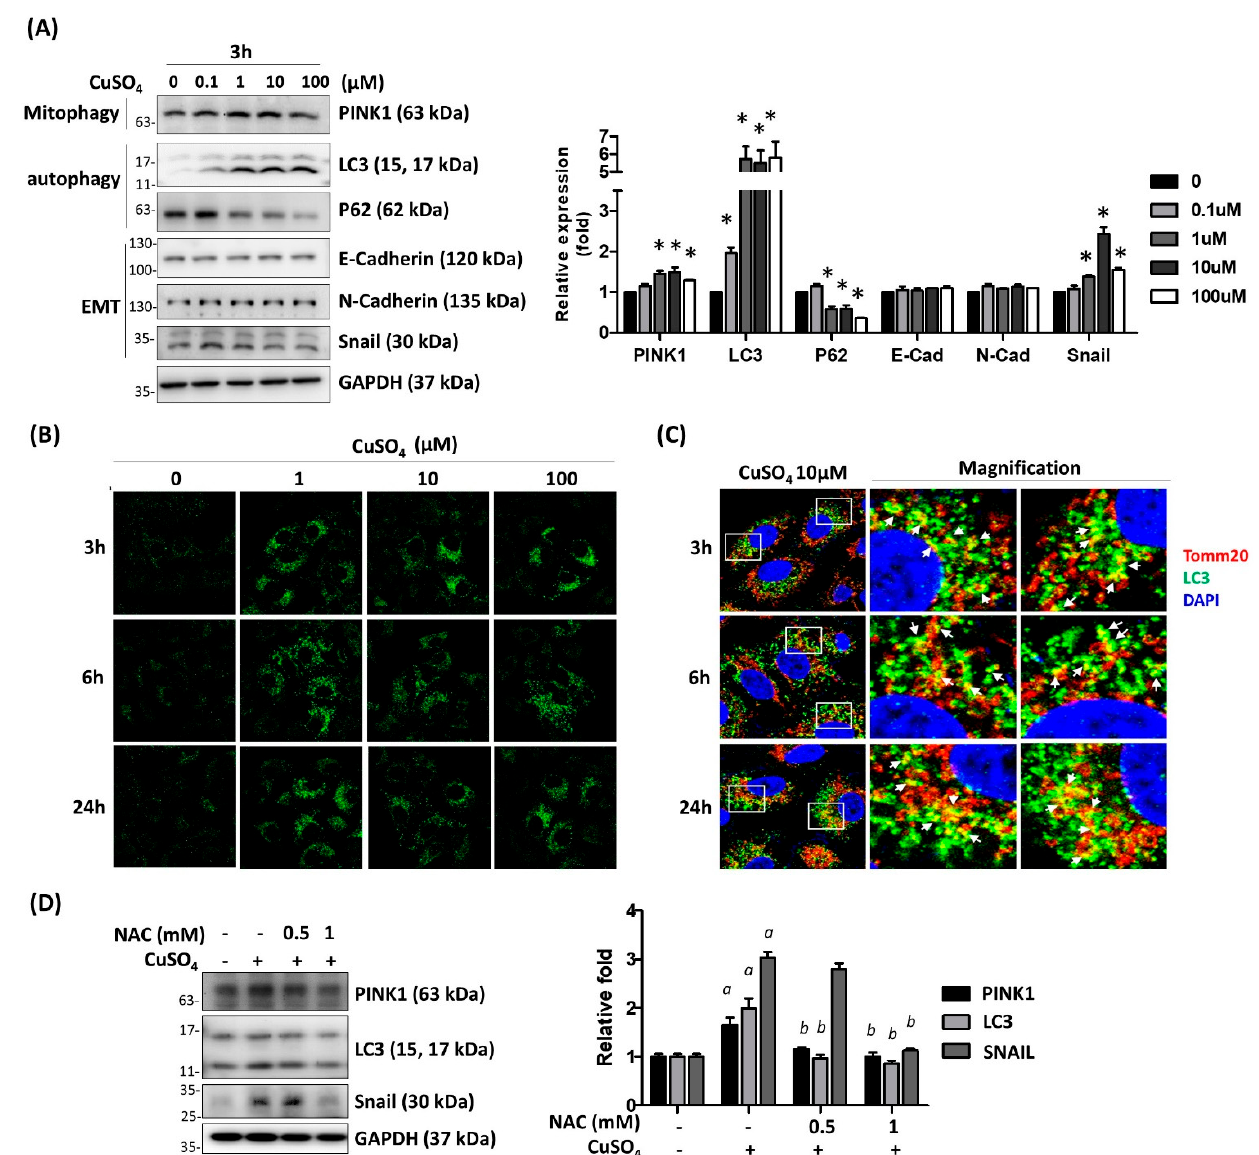
Figure 3. CuSO 4 induced autophagy and mitophagy of lung epithelial cells. ( A ) A549 cells were treated with various doses of CuSO 4 for 3 h. The protein expressions of mitophagy-, autophagy-, and EMT-related proteins were examined by Western blot. The quantitative results were shown in the right panel. Mean ± SEM were shown. *: p < 0.05. ( B ) A549 cells treated with various doses and time periods were fixed and applied to immunofluorescence staining using antibodies against LC3. ( C ) Co-localization of LC3 (green color) and Tomm20 (red color, indicating mitochondria) was shown in yellow color. ( D ) A549 cells were pretreated with 0.5, 1 mM NAC. After 2 h of treatment, the cells were treated in combination with 10 µ M CuSO 4 for 3 h, followed by Western blot analysis. a : p < 0.05 compared with the control group. b : p < 0.05 compared with CuSO 4 only group. The quantitative results are shown in right panel. The experiments were performed three times for quantification analysis, and the representative images are shown.